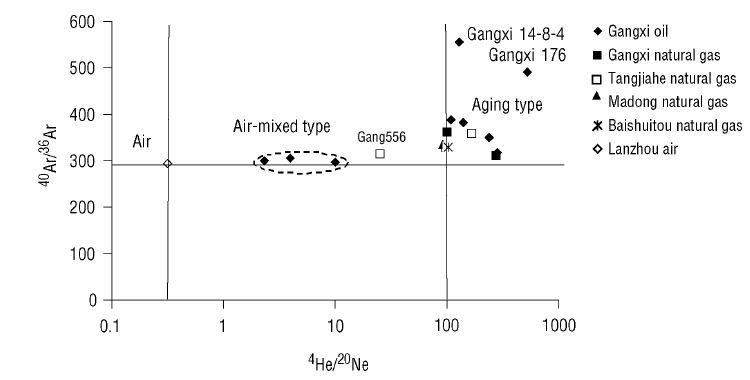
Fig. 6. Plot of 40 Ar/ 36 Ar versus 4 He/ 20 Ne of the crude oil from the Gangxi oil